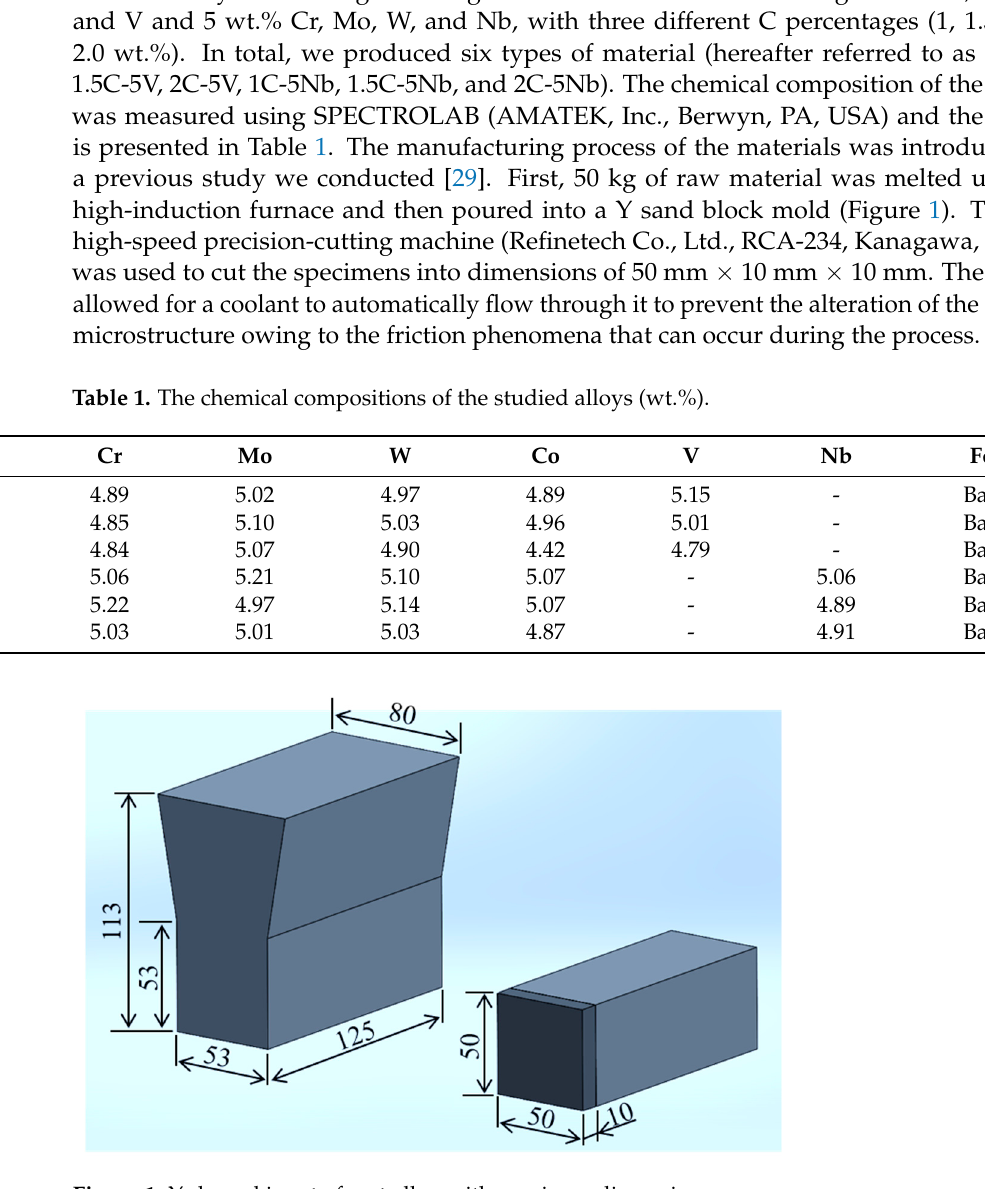
Figure 1. Y-shaped ingot of cast alloy with specimen dimensions.